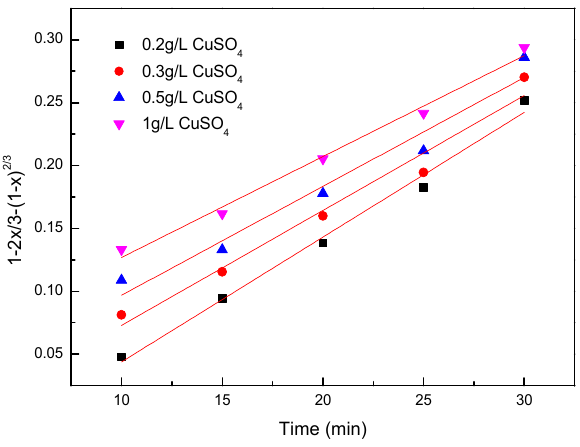
10 of 12 Table 4. Correlation coefficient (R 2 ) values for the different CuSO 4 concentrations and kinetic data. CuSO 4 Concentration (g/L)